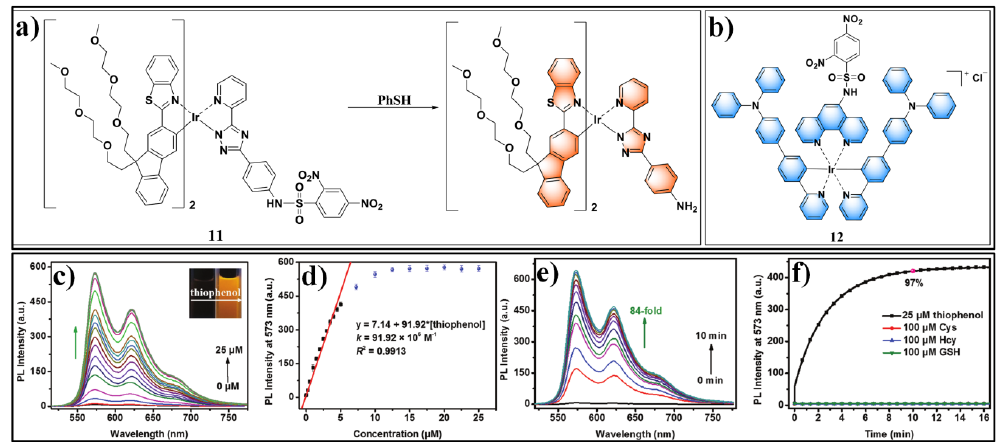
Figure 5. ( a ) Structure and reaction of probe 11 with PhSH. ( b ) Structure of probe 12 . ( c ) Phosphorescence spectra of probe 11 in the presence of different concentrations of thiophenol. ( d ) The correlation between phosphorescence intensity of probe 11 at 573 nm and concentration of thiophenol. ( e ) Phosphorescence spectra of probe 11 in the presence of thiophenol at different reaction times. ( f ) Fluorescence enhancement profile of phosphorescence intensity at 573 nm of probe 11 in the presence of thiophenol (five equivalents) or thiol species (20 equivalents) under nitrogen conditions. Reproduced with permission from Reference [71]; copyright Royal Society of Chemistry.